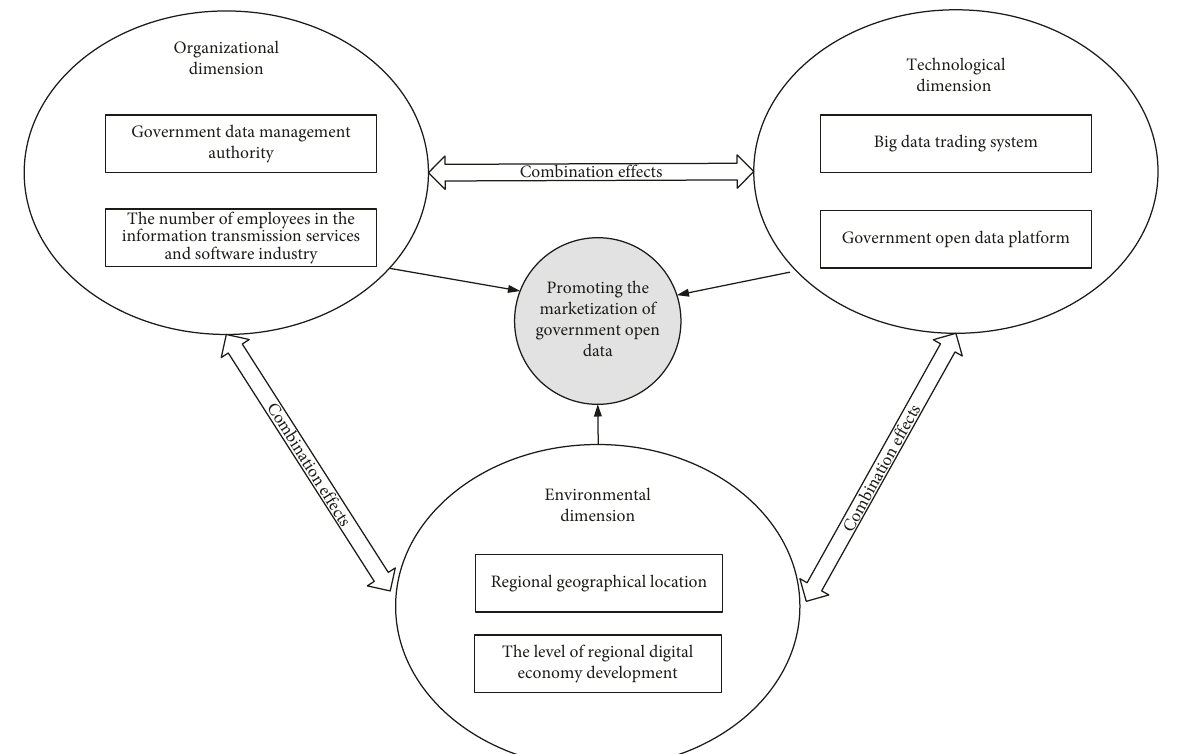
Figure 1: The theoretical model to promote the marketization of government open